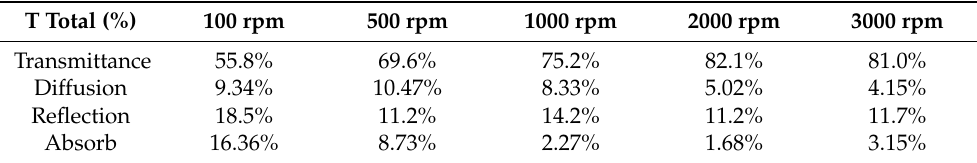
Figure 10. UV-Visible diffusion reflection spectra of CuCrO 2 thin films prepared at different rotating speeds from 100 to 3000 rpm and annealed at 600 °C. Table 2. Detailed values (transmittance, diffusion, reflection, and absorbance) of CuCrO 2 thin films prepared at different rotating speeds from 100 to 3000